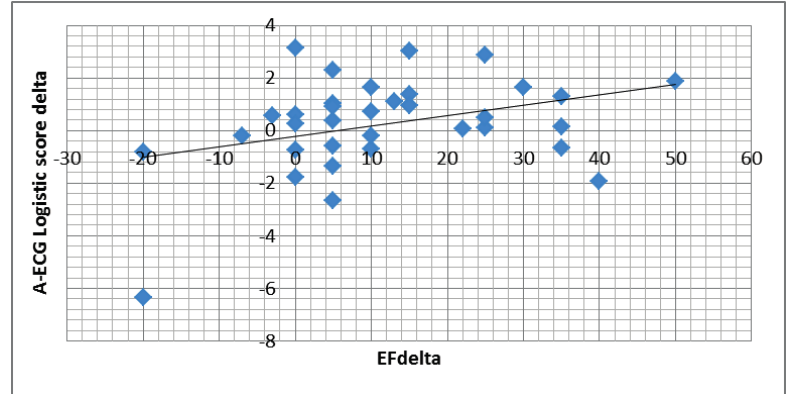
Figure 1. (Top): Baseline ejection fraction (EF) versus baseline A-ECG logistic score for left ventricular systolic dysfunction (LVSD), in all serial NICM patient ECGs; and (Bottom) Change in EF versus change in A-ECG logistic score.